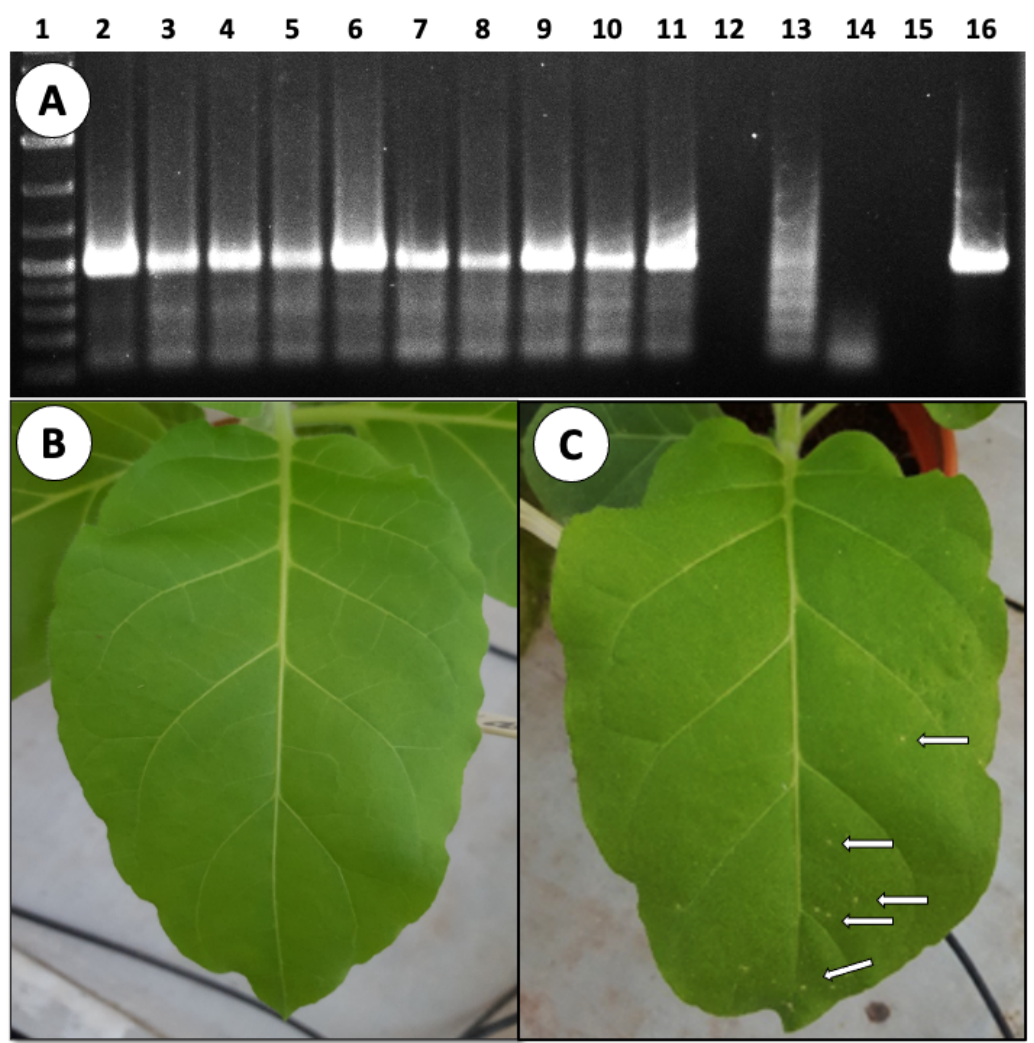
Figure 4. PCR analysis of tomato seeds for ToBRFV presence and infectivity test for seed-associated ToBRFV. ( A ) RT-PCR detection of ToBRFV in seeds harvested from infected plants. Each lane represents 15 seeds harvested from a different plant. Lanes: (1) Molecular weight markers; (2–11) Seeds harvested from infected plants; (12, 15) empty lanes; (13) seeds harvested from a noninoculated plant; (14) reaction mix; (16) Total RNA from an infected leaf. ( B , C ) Tobacco leaf ( N. tabacum cv. Xanthi–NN) was inoculated with a crude extract from 50 seeds harvested from healthy tomato ( B ) or from an infected tomato plant ( C ). Note the presence of local lesions (arrows). ToBRFV’s presence in the developed local lesions was validated by RT-PCR. Pictures were taken 72-hr after inoculation.